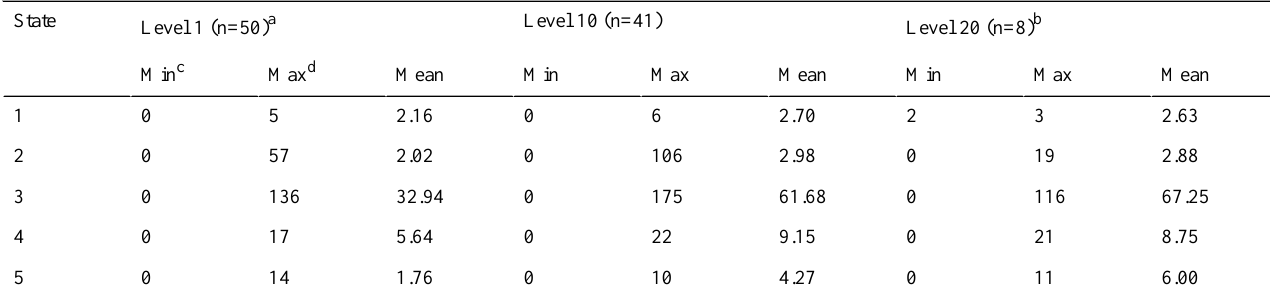
Table 6. Frequency by state for selected levels.